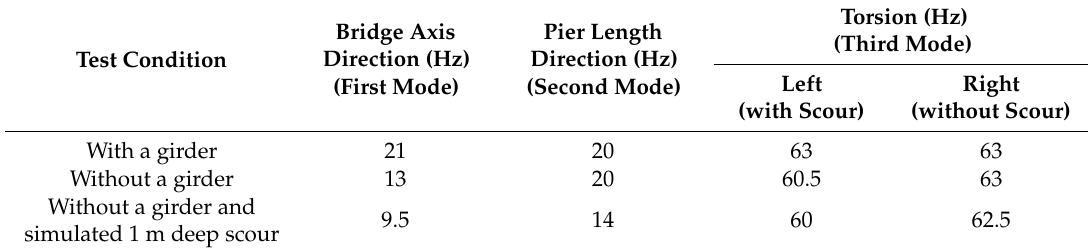
Figure 14. Third mode natural frequency for each field condition. ( a ) With a girder; ( b ) without a girder; and ( c ) 1 m deep scour on the ground adjacent to the pier. Table 3. Natural frequency results of the field pier according to the presence of a scour.